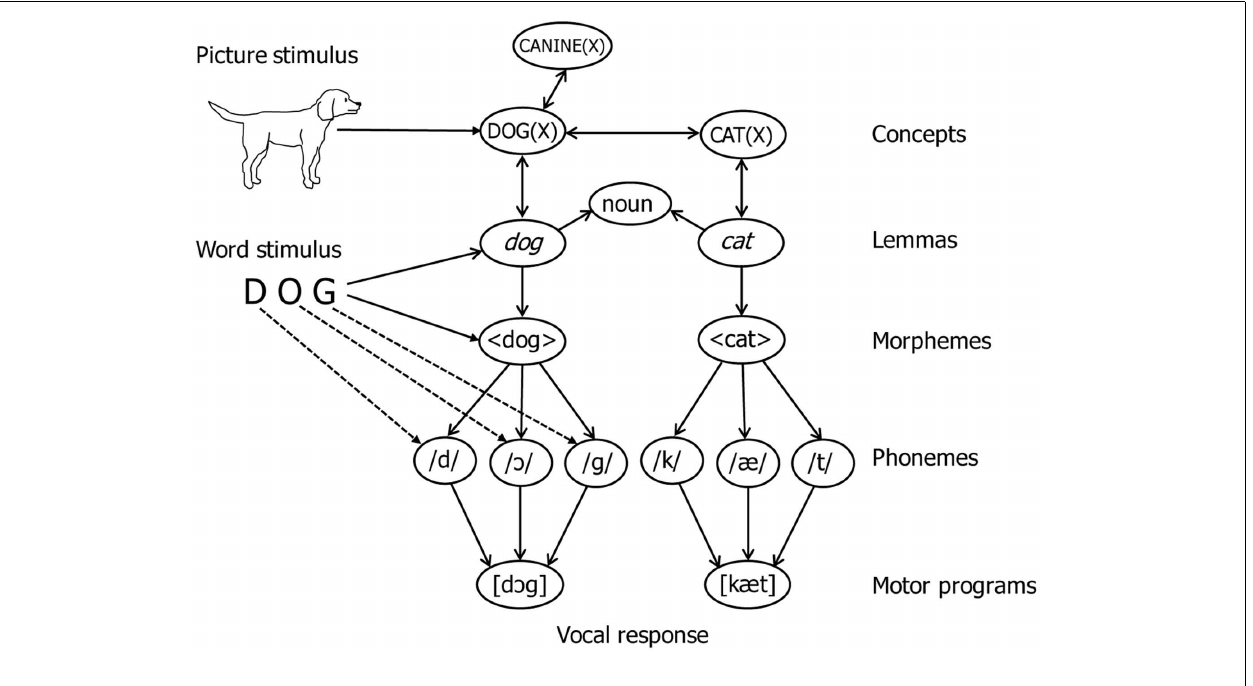
phoneme nodes, after which other nodes become activated through spreading activation.The dashed lines indicate grapheme-to-phoneme